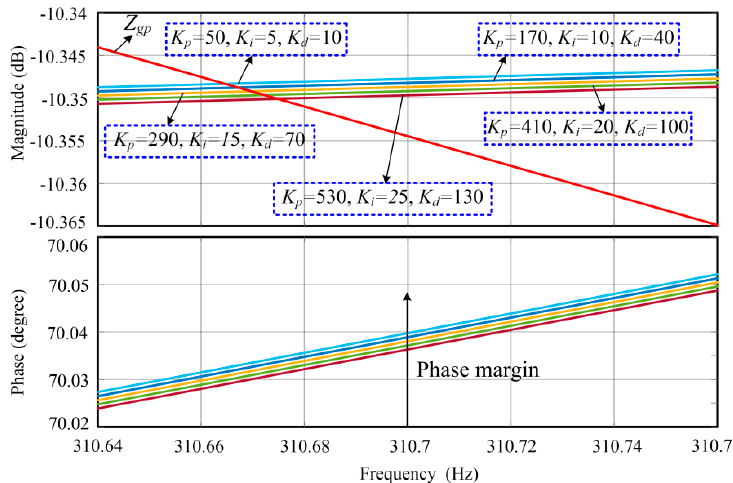
Figure 17. Bode plot of DFIG impedance and parallel compensated weak grid with different improved PLL parameters.